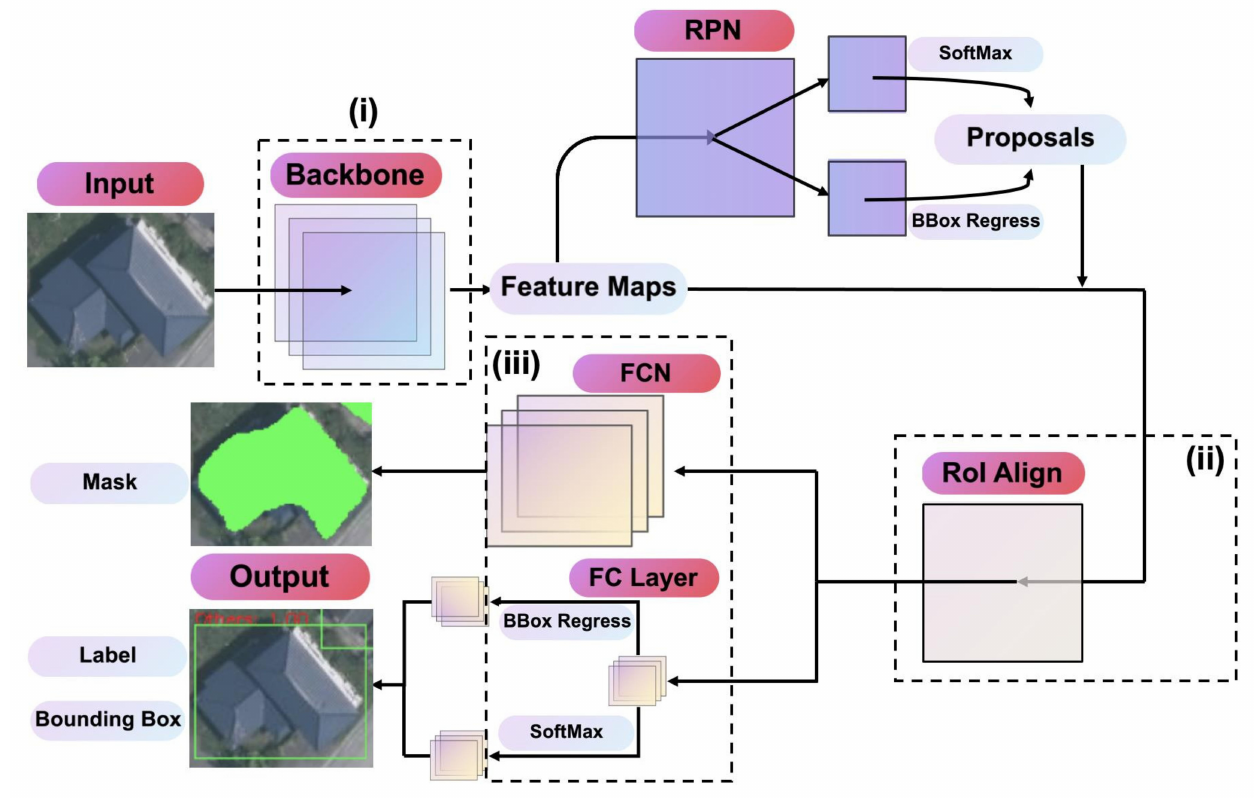
Figure 5. Structure of the Mask R-CNN algorithm. (i) is the structure of Feature Pyramid Networks, (ii) is the structure of RoI, and (iii) is the original NMS